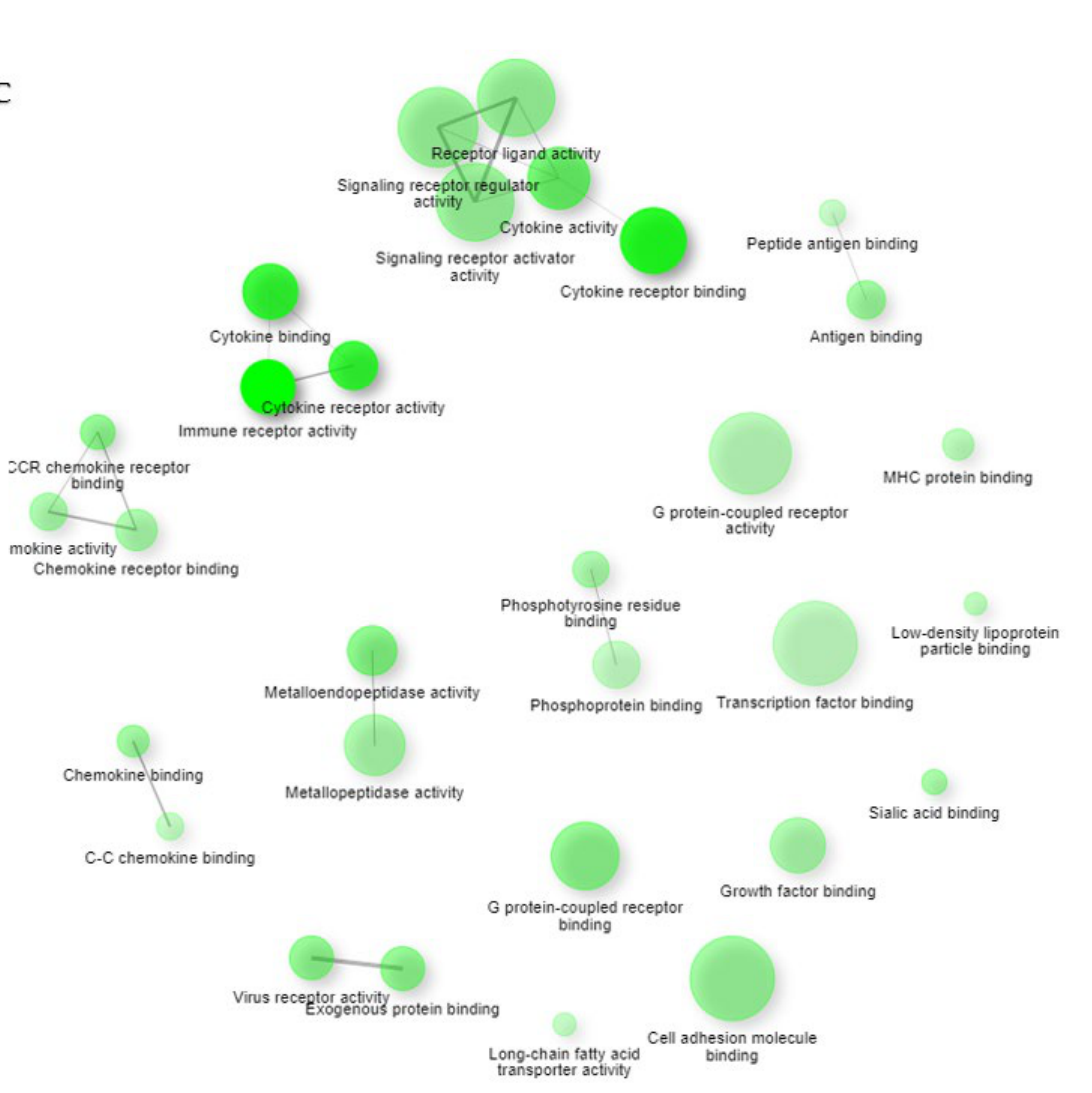
Figure 5. Pathway analysis with the GO molecular function with DEGs. ECRS-Ctrl ( A ), nonECRS- Ctrl ( B ), and Asp-Ctrl ( C ) showed the existence of significant enrichment pathways. Two pathways (nodes) are connected if they share 30% or more genes. Green and red represents down and up regulated pathways, respectively. Darker nodes show more significantly enriched gene sets. Bigger nodes represent larger gene sets. Thicker edges represent more overlapping genes.